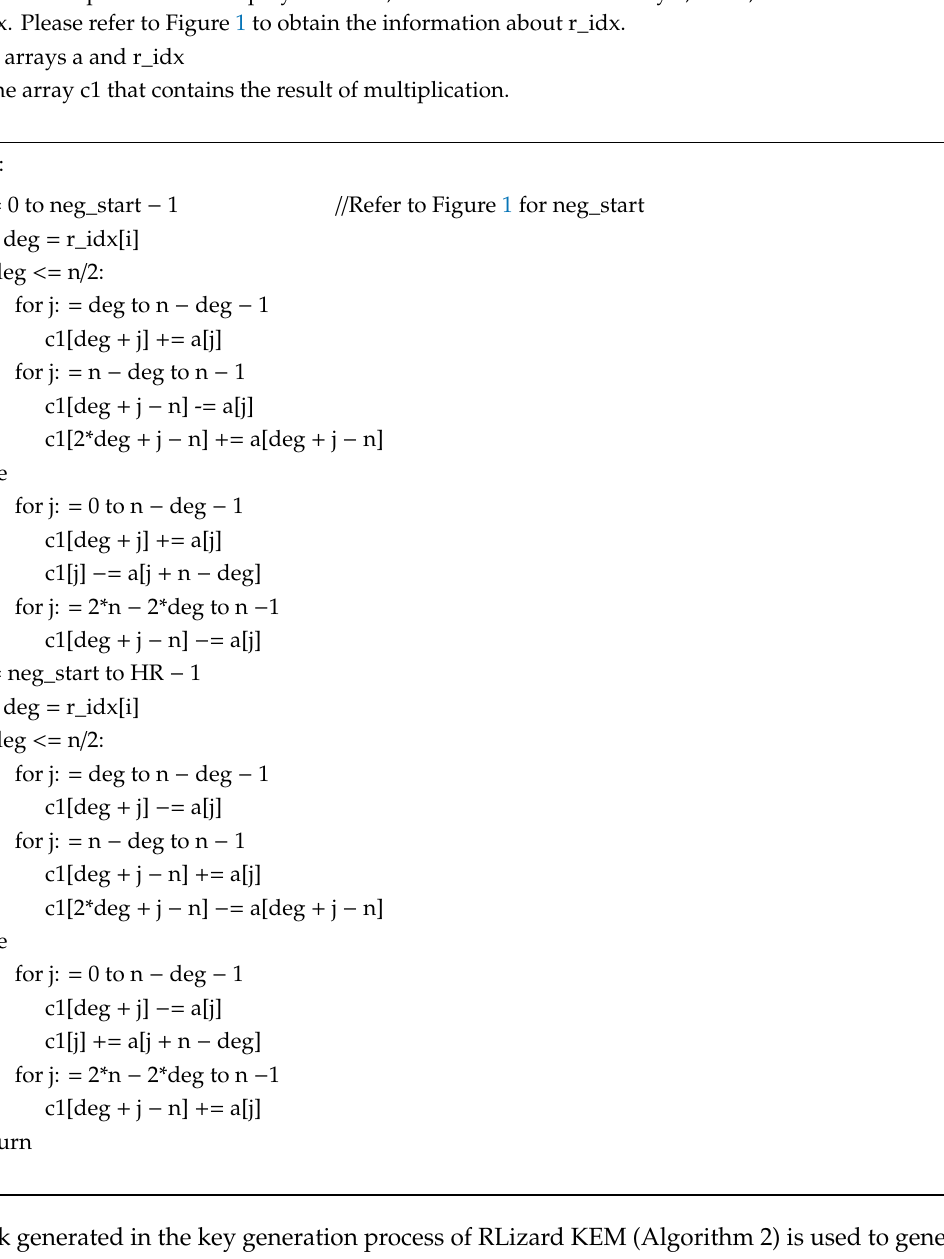
Algorithm 5. The proposed